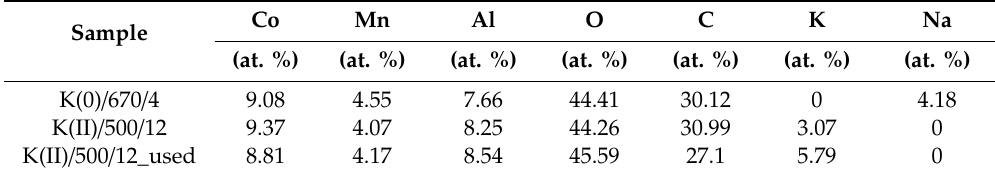
Table 4. Surface concentrations determined using X-ray photoelectron spectrometry (XPS) data evaluation in at. %. Co Mn